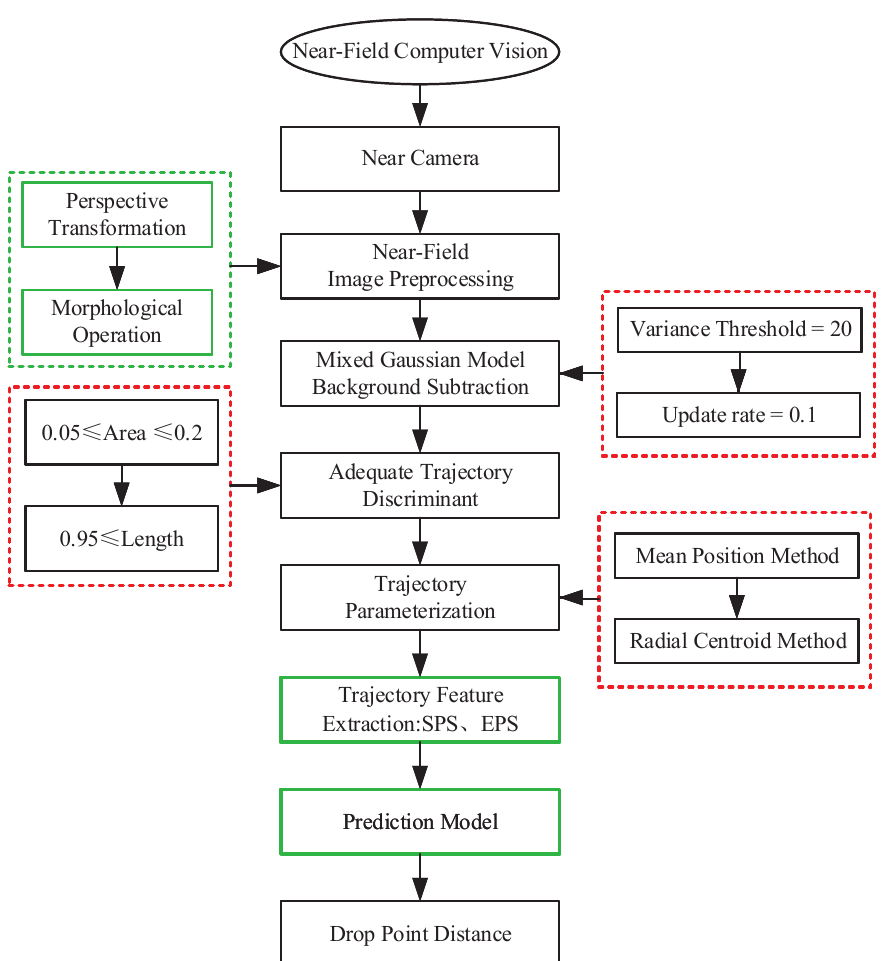
Figure 8. Workflow of the improved NFCV system, green and red frame represent previous and current work about fire robot, respectively.